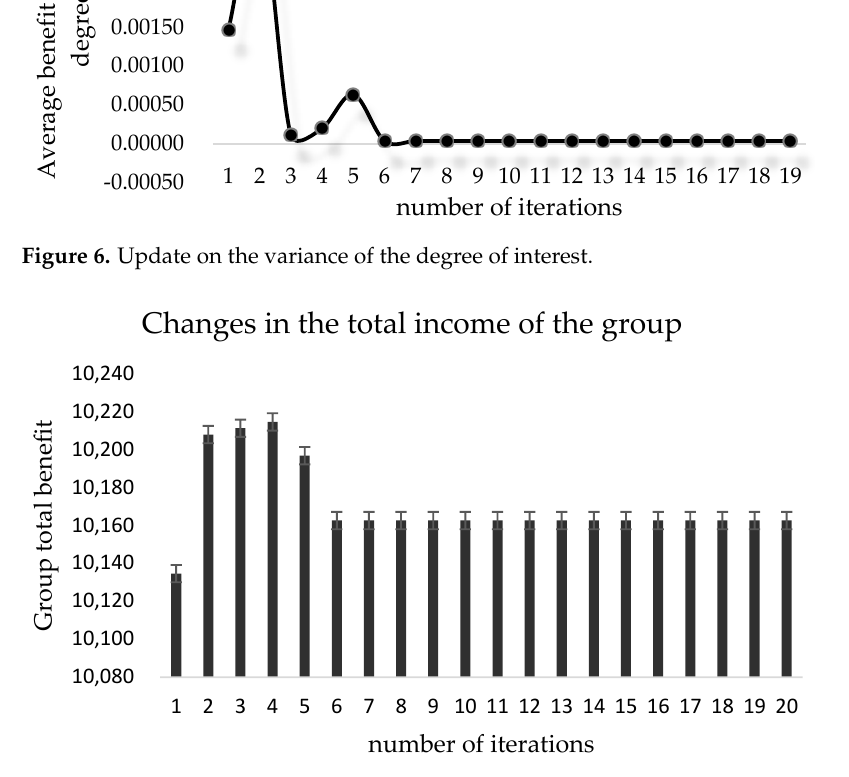
Figure 8. Relative deprivation and its variance update. 5.3. Parameter Analysis By adjusting some parameters, the applicability of the model to this problem is fur- ther verified. Assuming that the scale of profit distribution has changed now, the profit distribution in the final order distribution scheme shown in this paper is to be adopted as the initial profit distribution situation, and other parameters remain unchanged. The change trends of the operation results and key indicators in the distribution process are shown in Tables 5 – 8 and Figures 9 – 11, respectively. Table 5. Result of benefit distribution after adjusting parameters. Agent Contribution Value AC